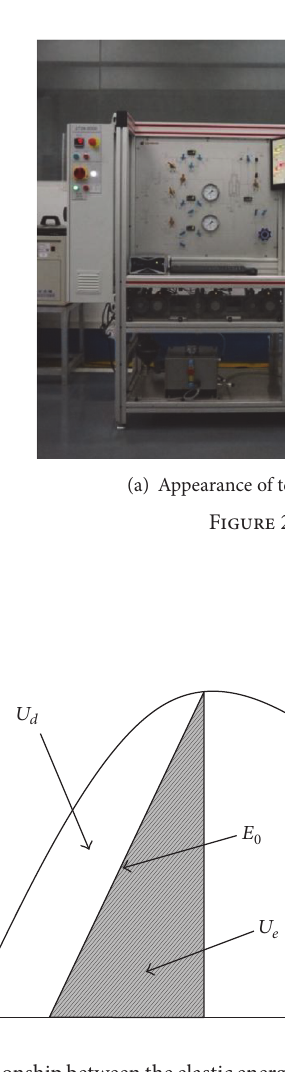
Figure 3: Relationship between the elastic energy and the dissipated energy